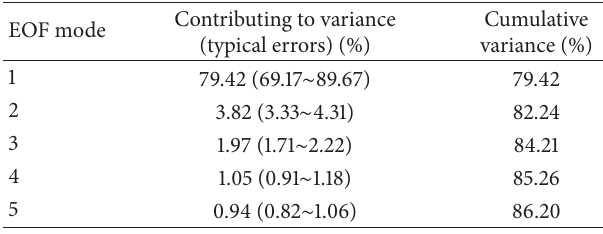
Table 2: The contribution of eigenvalue at each EOF mode of AOT C.